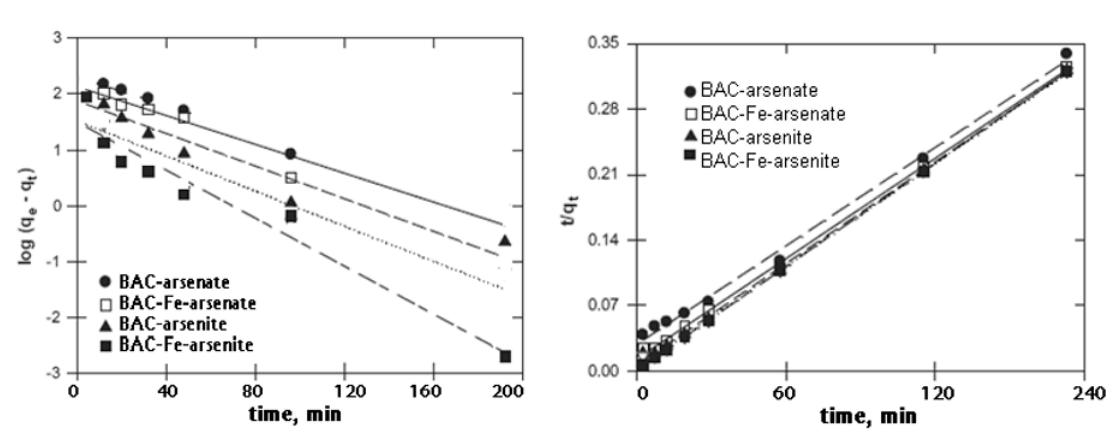
Figure 10. Pseudo-first order kinetic and pseudo-second kinetic models of arsenite and arsenate on BAC and